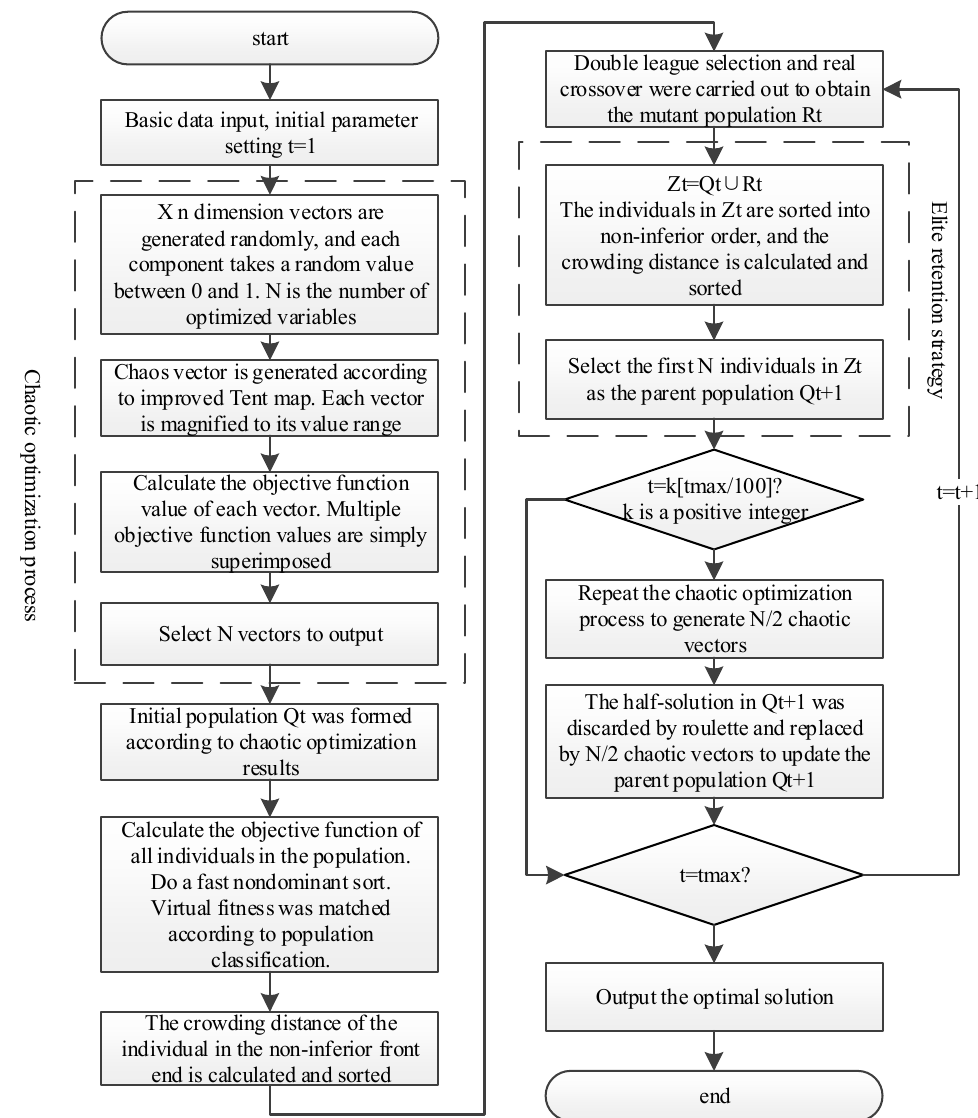
Figure 1. Flow chart of the Non-Dominated Sorting Genetic Algorithm-II (NSGA-II) algorithm based on tent mapping.